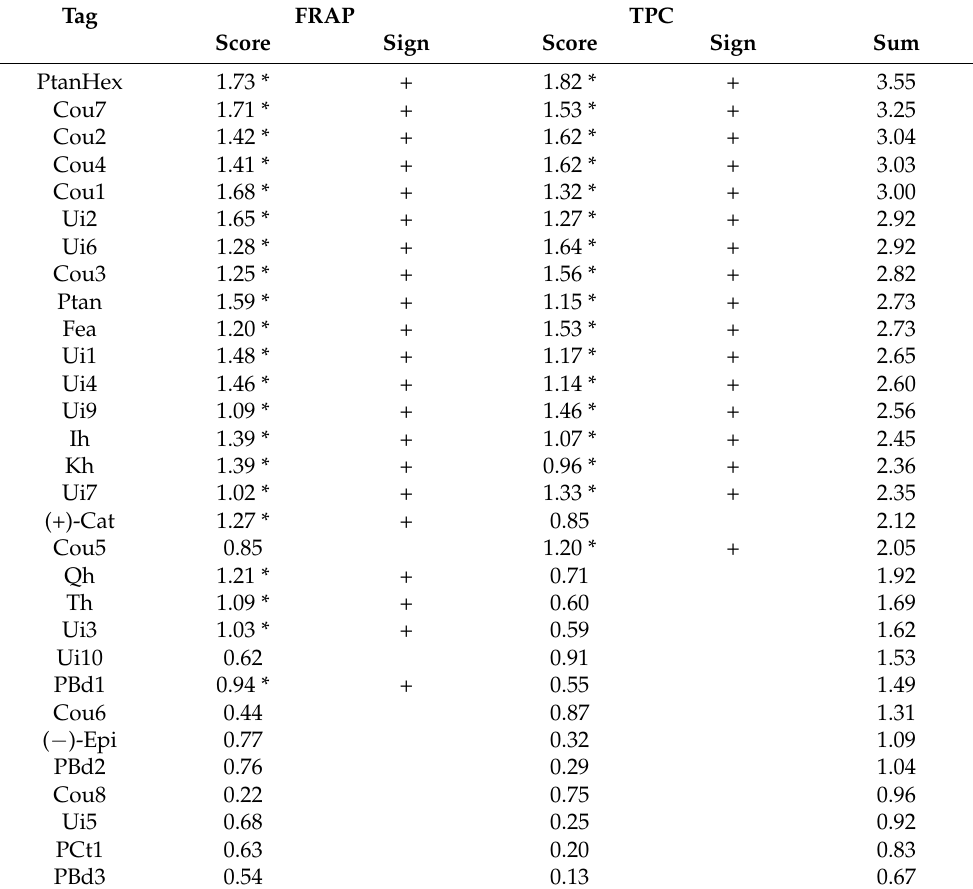
Table 4. Summary of the chemometric evaluation of the antioxidant efficiency of Norway spruce cone polyphenols. FRAP: Ferric Reducing Antioxidant Power; TPC: Total Polyphenol Content. “Sign” indicates the type (positive/negative) of the significant correlation between compounds’ concentration and FRAP/TPC. Significant correlations (for p < 0.05, n = 11, | R | ≥ 0.60) were marked with an asterisk. For the interpretation of the tags, please refer to Table 1. Tag FRAP TPC Score